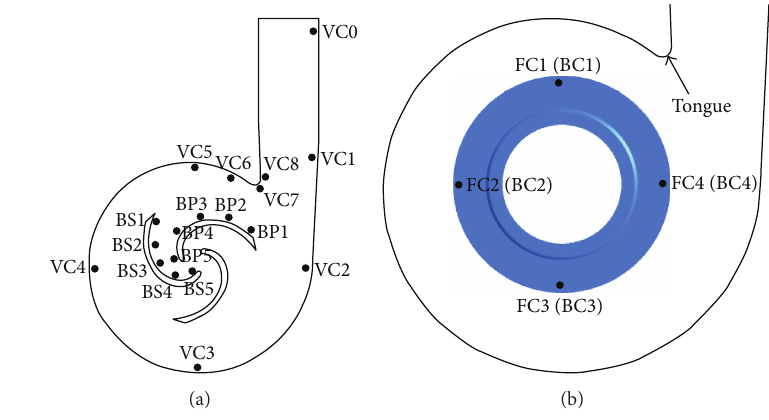
Figure 3: Distribution of pressure recording